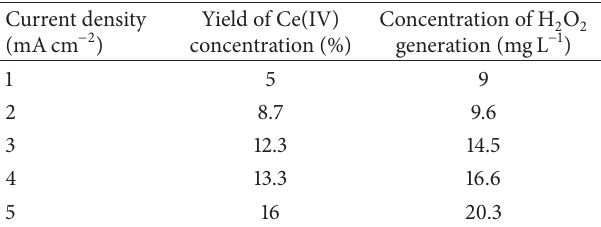
Table 1: Effect of the current density on the Ce(IV) and H electrogeneration during a paired photoelectrochemical oxidative